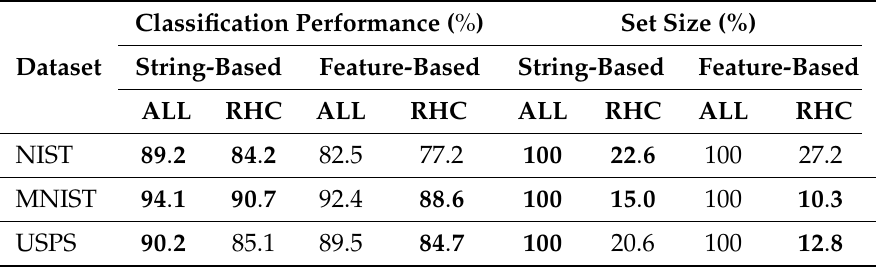
Table 2. Results in terms of F 1 as classification rate and resulting set size for the different corpora considered. ALL and RHC stand for the classification results obtained with the initial set and the reduced one, respectively. Set size percentages are obtained referring to the ALL case for each corpus and data representation. Standard deviation values are not reported as they are lower or equal than 0.01. Bold values highlight the non-dominated elements for each